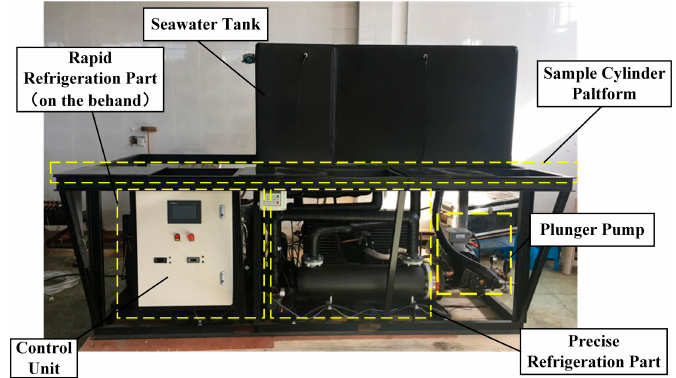
Figure 2. Pressure maintenance and temperature control device.